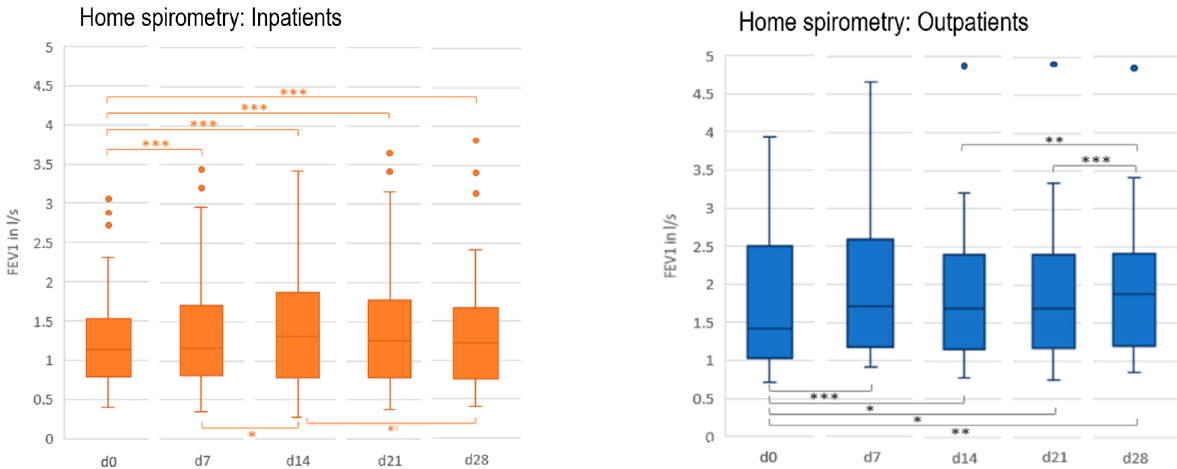
Figure 2. Home spirometry FEV1 (l/s) inpatients and outpatients, days 0–28. *p < 0.05, **p < 0.01, ***p < 0.001